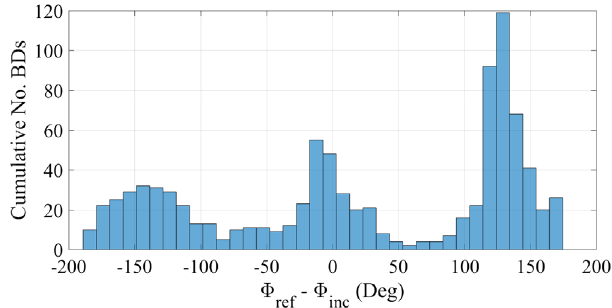
FIG. 33. Phase difference between forward and reflected signals during breakdowns. The three distinct peaks are separated by 120° corresponding to the phase advance per cell.